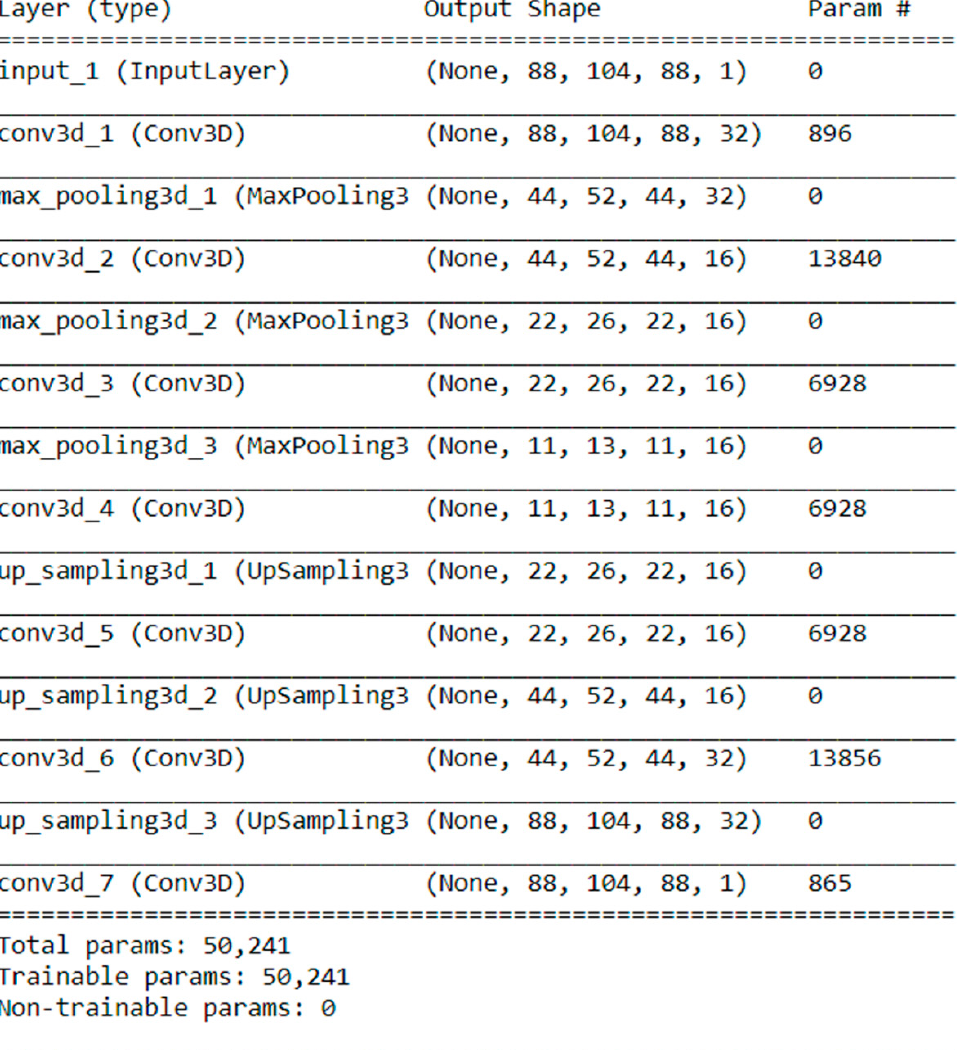
Figure 1. The structure of the autoencoder, which consists of six 3D convolution layers, three max-pooling layers, and three upsampling layers, resulted in compressed images with sizes of (11, 13, 11, 16) for feature extraction.